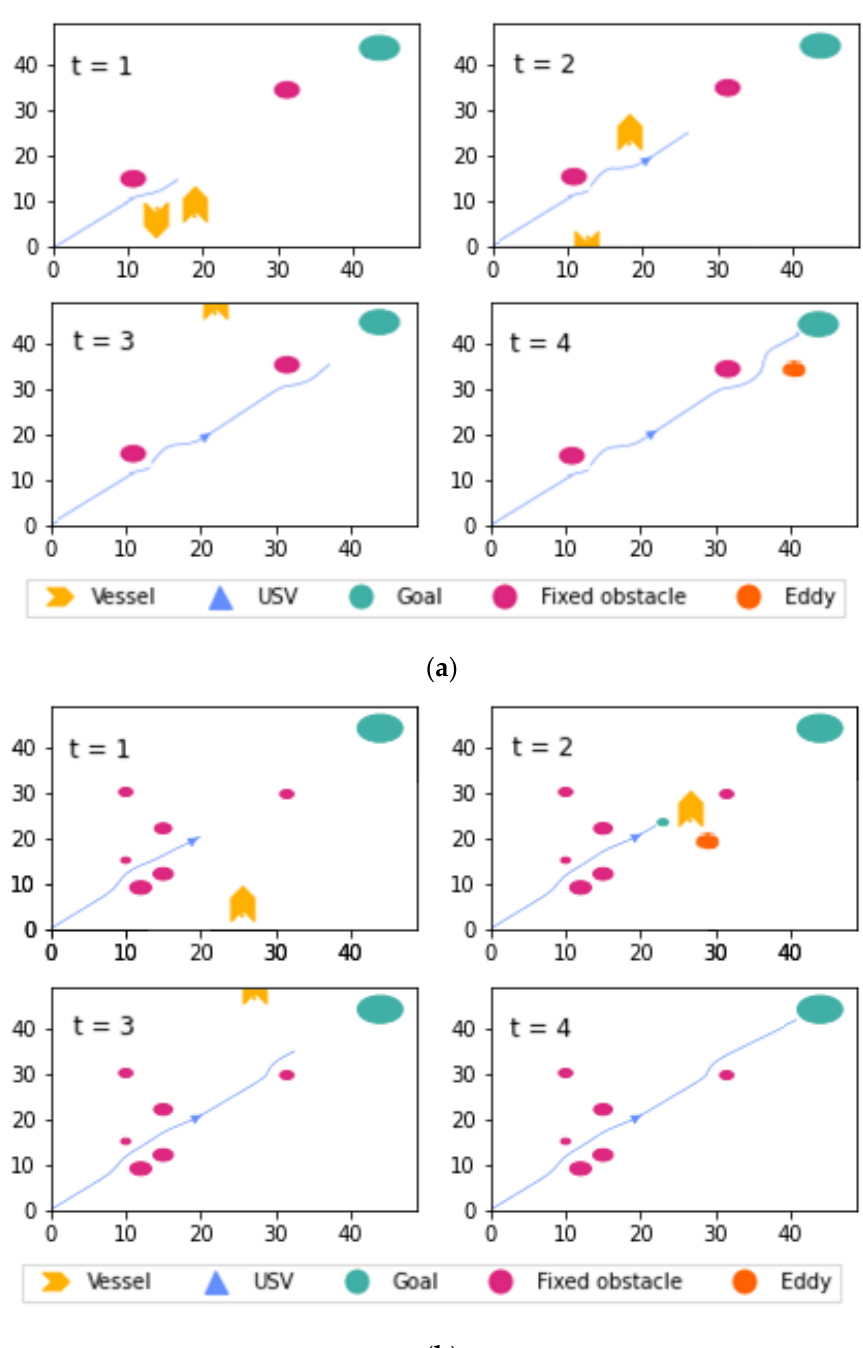
Figure 8. ( a ) USV path avoiding: fixed obstacles, vessel in movement, and eddy (1). ( b ) USV path avoiding: fixed obstacles, vessel in movement, and eddy (2).